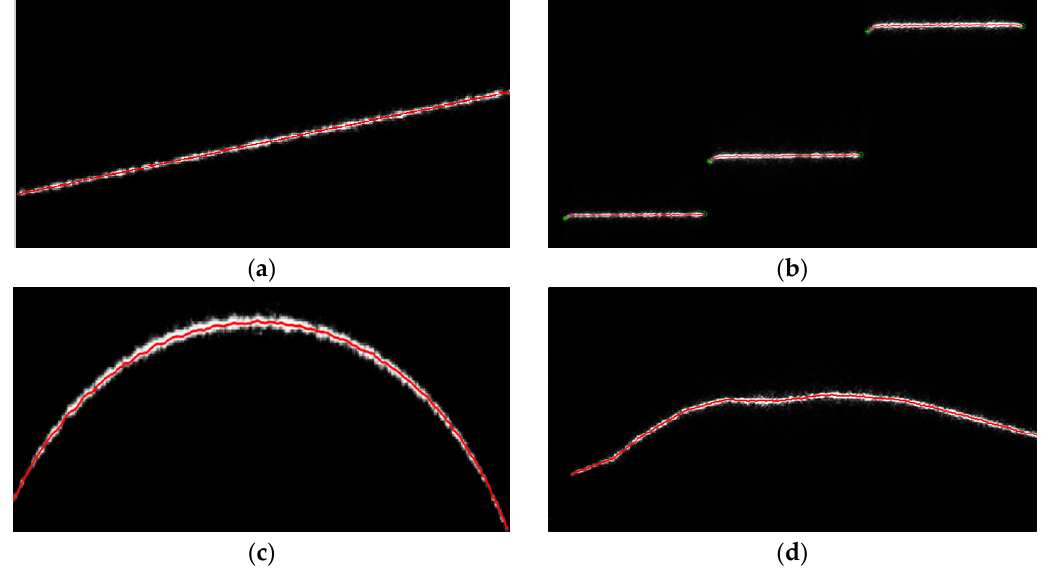
Figure 6. Center extraction results for different stripes: ( a ) the sloping straight line; ( b ) the steps; ( c ) the arc; ( d ) the random stripe.